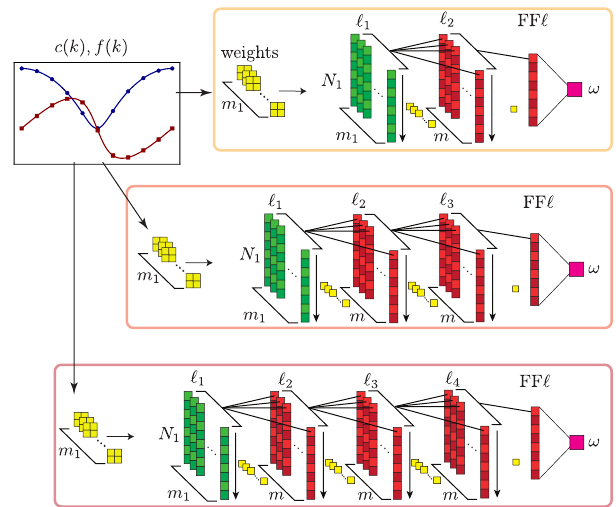
Figure 8: Structure of the CNNs forming the ensemble . The input for the CNNs is a 2 × L dataset with the correlation functions c ( k ) , f ( k ) . First, the input is filtered by a layer of m 2D convolutional weights (in yellow) trained independently on each 1 = L − 1 (the first set of network. Each weight produces one array of length N 1 green columns denoted by ℓ ) for a total of m arrays. Then each network has a 1 1 different number of additional hidden layers (columns in red): ℓ , ℓ , ℓ from the 2 3 4 top. Each of these layers performs a 1D convolution using the weights in